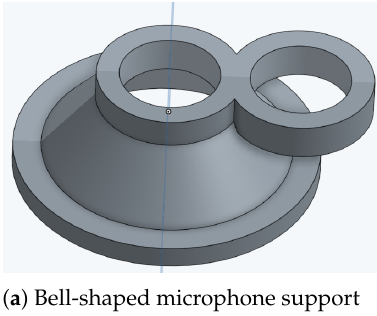
Figure 1. Illustration of the microphone setup.